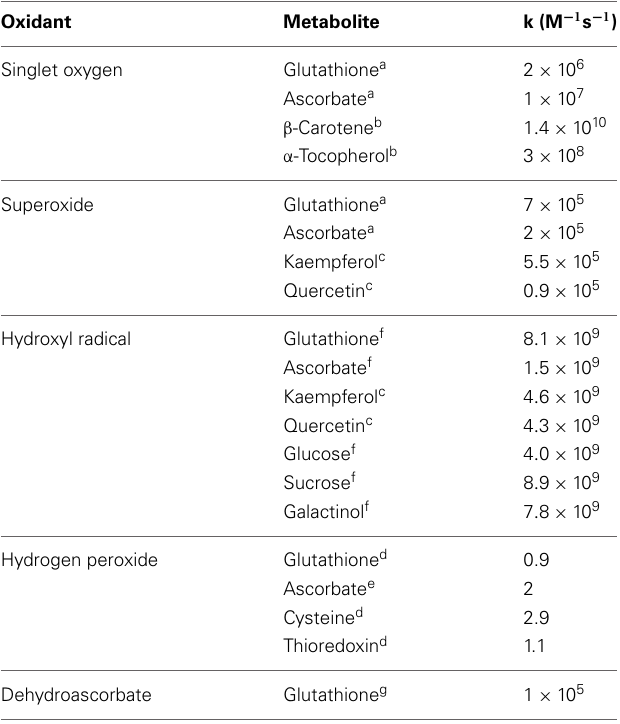
Table 1 | Rates of nonenzymatic reactions between glutathione and various